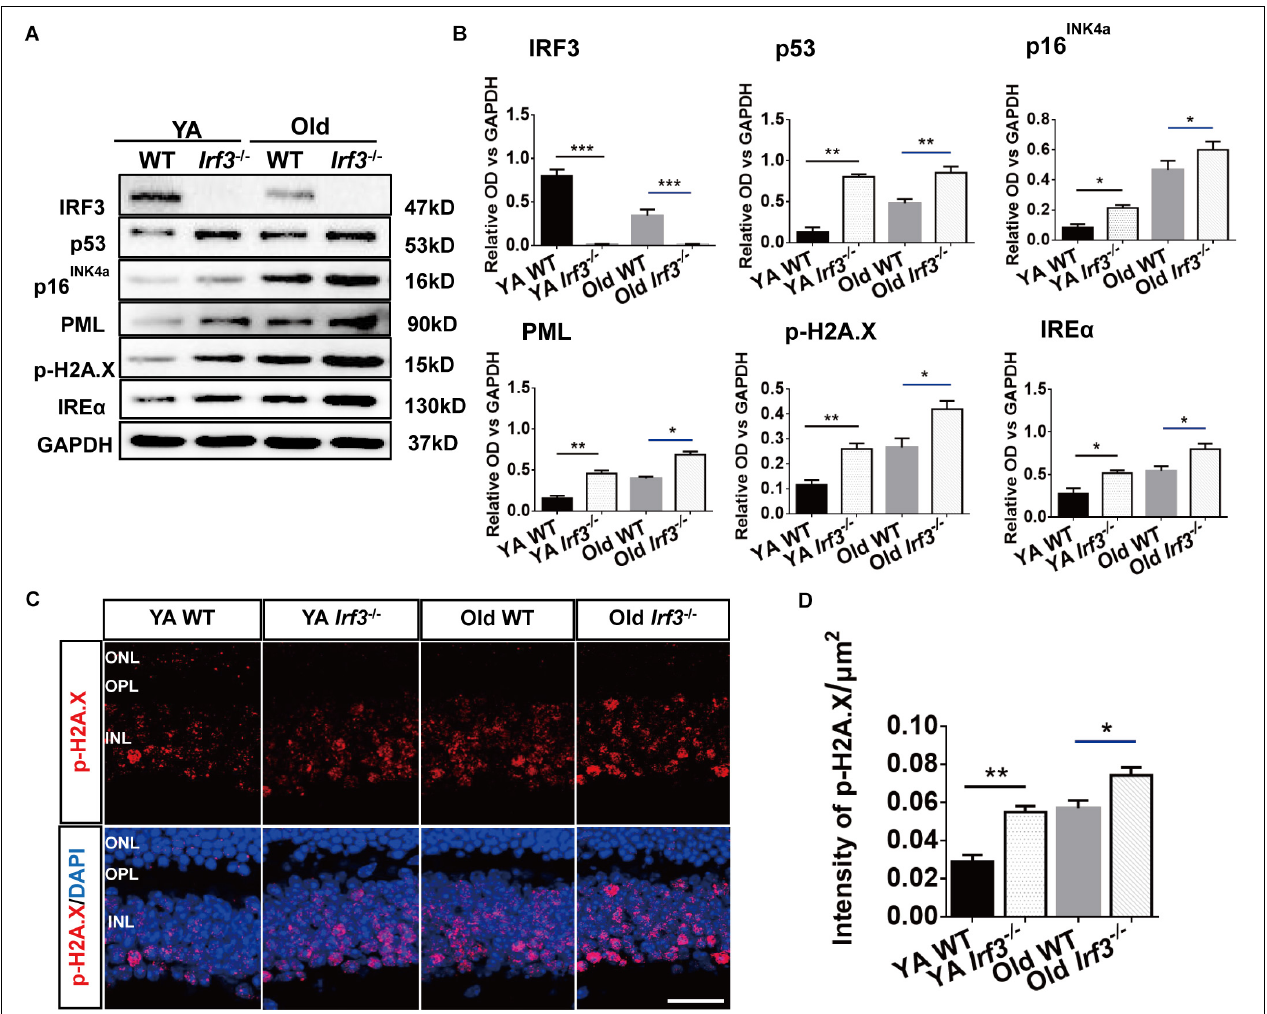
FIGURE 5 | IRF3 deficiency promotes the expression of senescence-related markers in retina. (A) Representative immunoblots show the expression of senescence markers (p53, p16 INK 4 a , PML, IRE α , p-H2A.X) and IRF3 in YA WT, Old WT, YA Irf3 − / − and Old Irf3 − / − mice. GAPDH was used as the loading control. (B) The quantification of IRF3 protein expression and the senescence markers. Data are presented as mean ± SEM ( ∗ p < 0.05, ∗∗ p < 0.01, ∗∗∗ p < 0.001, n = 6 per group). (C) Expression and localization of p-H2A.X in retinas of YA WT, Old WT, YA Irf3 − / − and Old Irf3 − / − mice. Scale bars = 30 µ m. (D) The quantification of fluorescence intensity of p-H2A.X expression. Data are presented as mean ± SEM ( ∗ p < 0.05, ∗∗ p < 0.01, n = 5 per